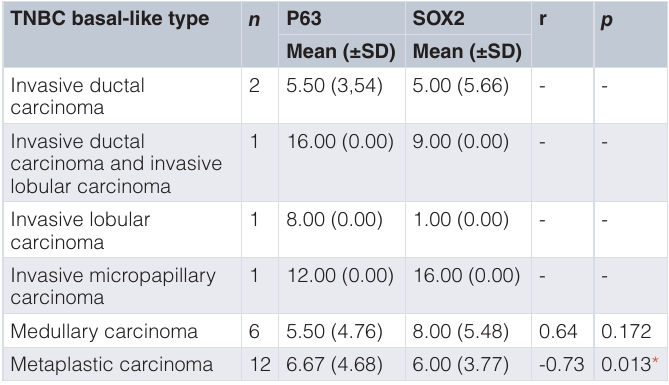
Table 3. Correlation between immunoexpression of P63 cytoplasm and SOX2 in Basal-like type